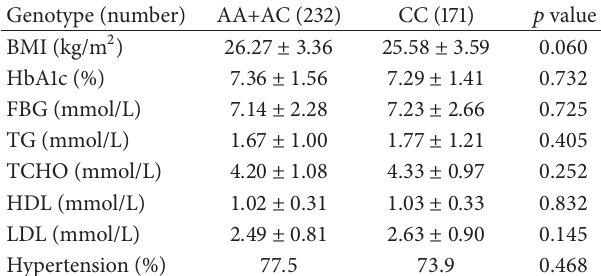
Table 5: Characteristics of different genotype at